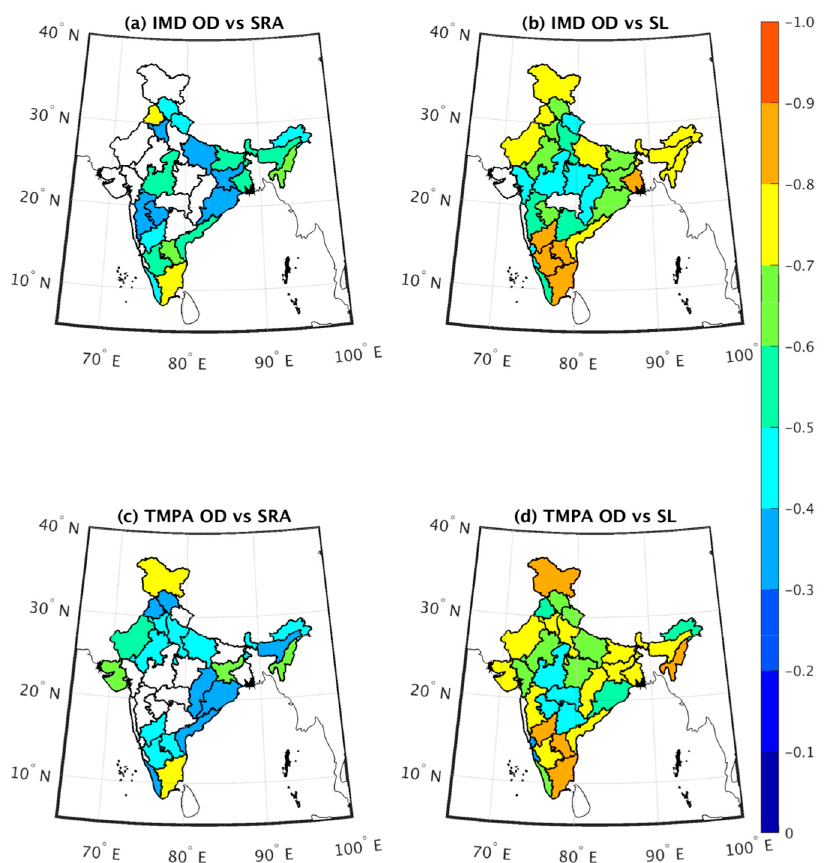
Figure 4. The correlation of the onset date (OD) in each of the MSD with corresponding ISM seasonal ( a , c ) rainfall and ( b , d ) length anomalies using ( a , b ) IMD, ( c , d ) TMPA rainfall datasets. Only statistically significant values at 90% significance level is shaded. SRA and SL in the panel titles refer to Seasonal Rainfall Anomaly and Seasonal Length, respectively. Note that the correlations range from 0 to − 1.